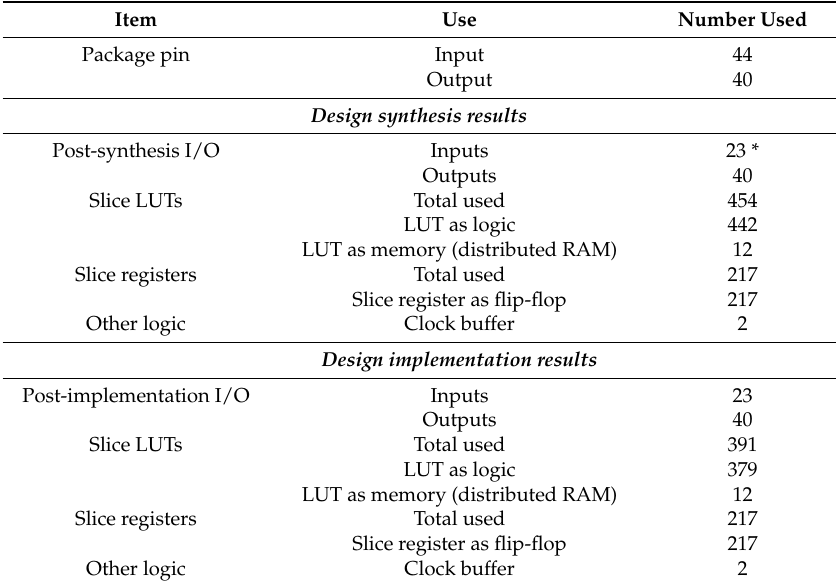
Table 3. Artix-7 FPGA resource utilization in the case study design. 609